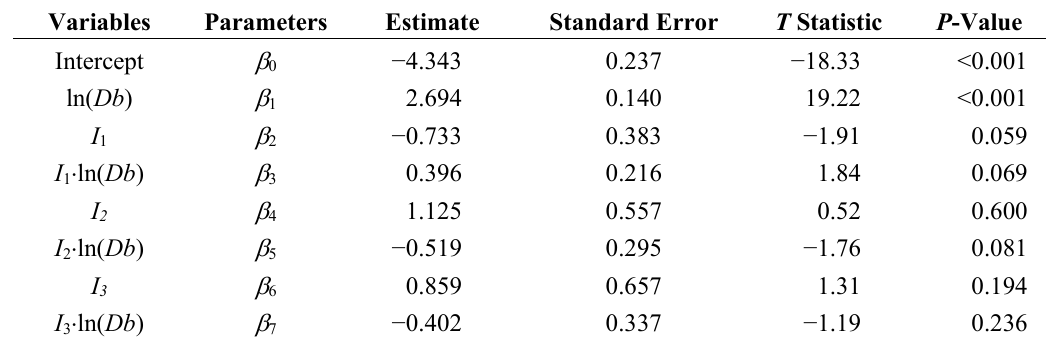
Table 2. Parameter estimates for the allometric equation to predict the Paulownia resprout biomass (kg of dry mass) according to the basal diameter ( Db ; cm) and treatments (Equation (2)); P -values under 0.05 indicate that the model coefficient differed significantly from 0 (at the 5% level of significance); number of cases: 111 (9 observations with /DFFIT/ > 0.52 were considered influential points and they were removed from the model).